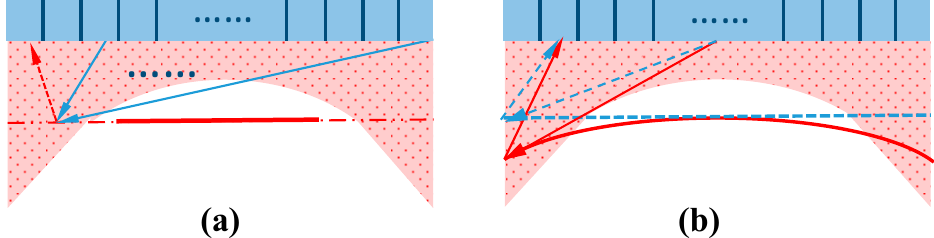
Figure 18. Two reasons why a uniform linear array causes error in CPWC: ( a ) discontinuous plane wave and ( b ) plane wave with a certain curvature. The blue line describes the ideal situation when all the elements of the existing MULA transmit and receive at the same time. The red line is the real situation. The red area indicates the possible imaging area with calculation error.